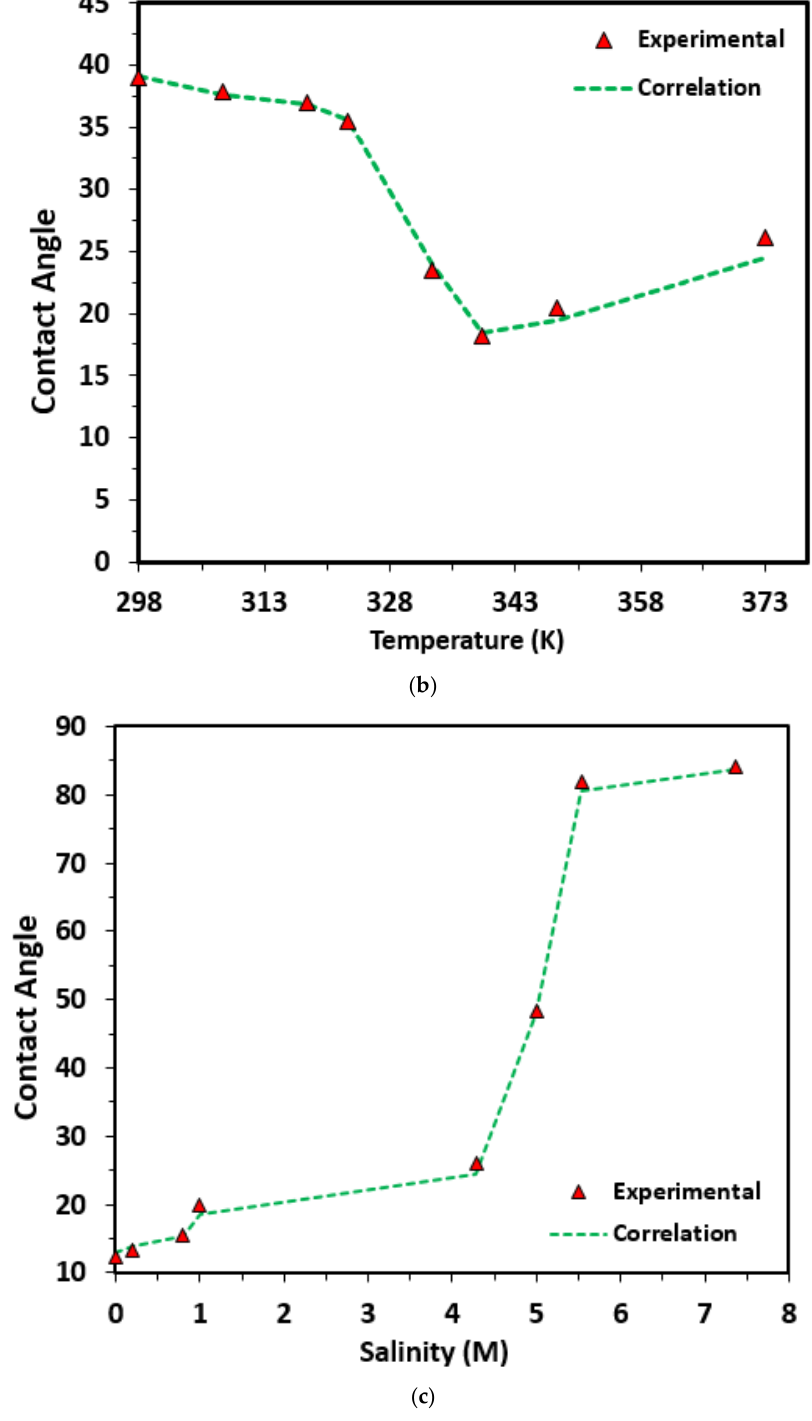
Figure 11. Comparison of the contact angle variation for the correlation implemented in this study with experimental data. ( a ) Contact angle versus pressure; ( b ) Contact angle versus temperature; and ( c ) Contact angle versus salinity.